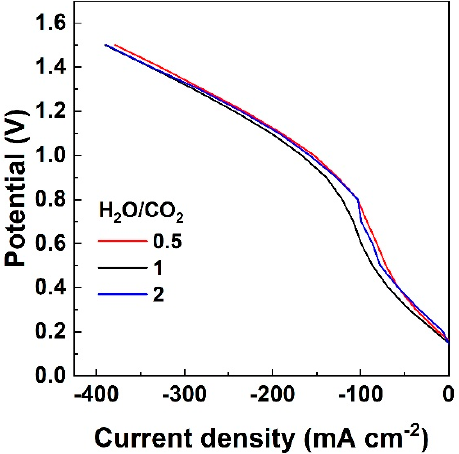
Figure 4. Current density-voltage (iV) curves recorded at 900 °C under electrolysis of the H 2 O/CO 2 mixtures, for three S/C ratios of 0.5, 1 and 2, in balance with He in the fuel electrode side and pure oxygen in the oxygen electrode side in all cases.